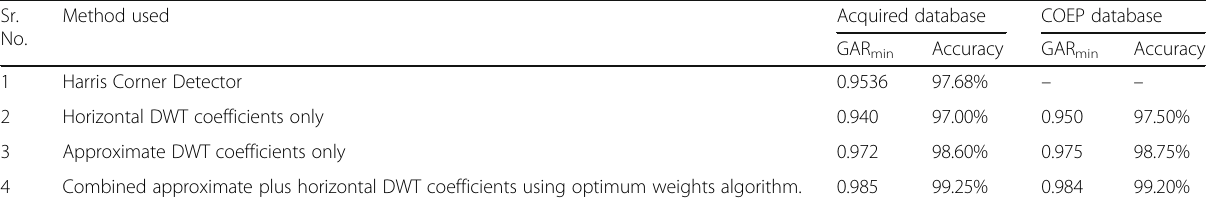
Table 9 Comparison of detection parameters among different methods Sr. No.